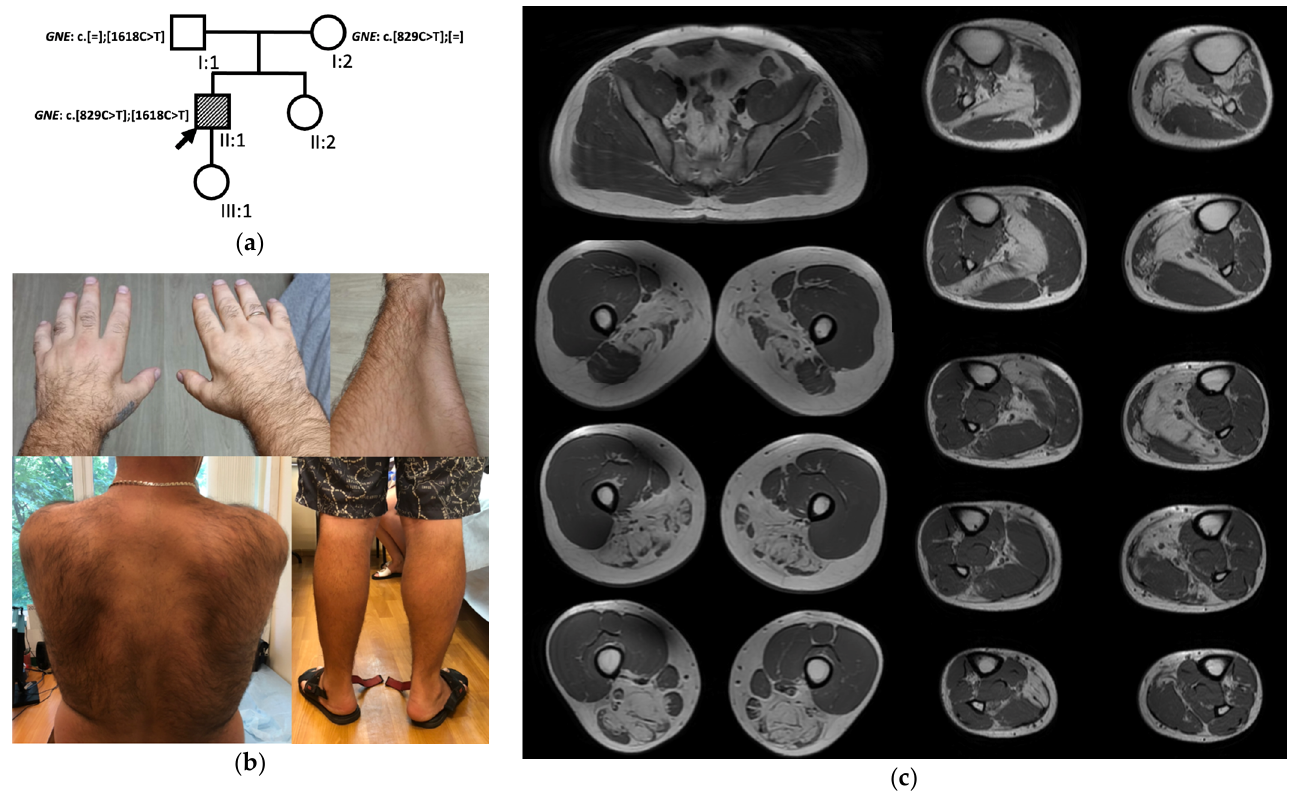
Figure 5. The patient No. 18.1. with atypical GNEM. ( a ) Genealogy; ( b ) Hands and left lower arm muscles’ atrophy, asymmetrical atrophy of lower leg muscles; ( c ) T1-weighted muscle MR-images of the pelvic girdle and lower limbs.